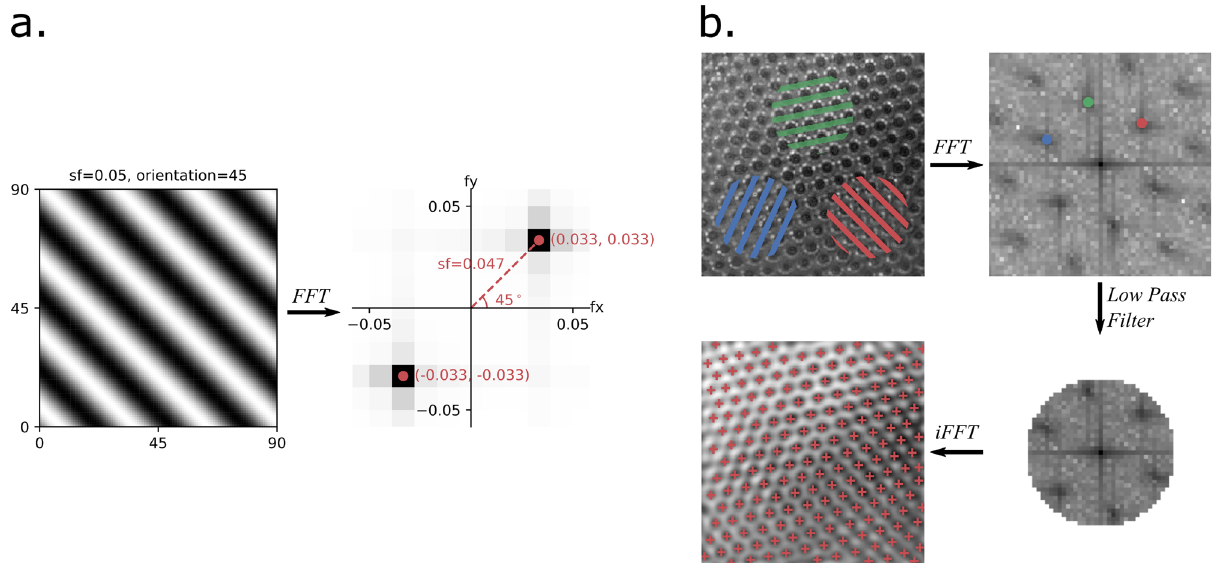
Fig. 4 The ommatidia detecting algorithm (ODA) extracts periodic signals in a 2D image using the FFT. a A 2D sinusoidal grating with a spatial frequency of .05 and orientation of 45° (left) and its reciprocal image (right). In the frequency domain of a 2D FFT, called the reciprocal space, gratings are represented by an x- and y-frequency. The polar coordinates represent visual properties of the corresponding grating. The radial distance is a grating ’ s spatial frequency, with high frequencies farther from the origin. The polar angle is the grating ’ s orientation, which is perpendicular to the grating ’ s wavefront. Notice that the reciprocal space has local maxima (in red) approximately equal to the input grating parameters (polar angle = 45° and radial distance = .047 ± .005). b The ODA pipeline for fi nding ommatidial centers. In a hexagonal lattice, there are three major axes (here in blue, green, and red). Each axis corresponds to a 2D spatial frequency (and it ’ s negative), visible in the image ’ s reciprocal space. The periodic nature of the axes results in harmonic frequencies. A low-pass fi lter returns a version of our original image primarily representing these three axes. The center of each ommatidium is found at the local maxima of the fi ltered